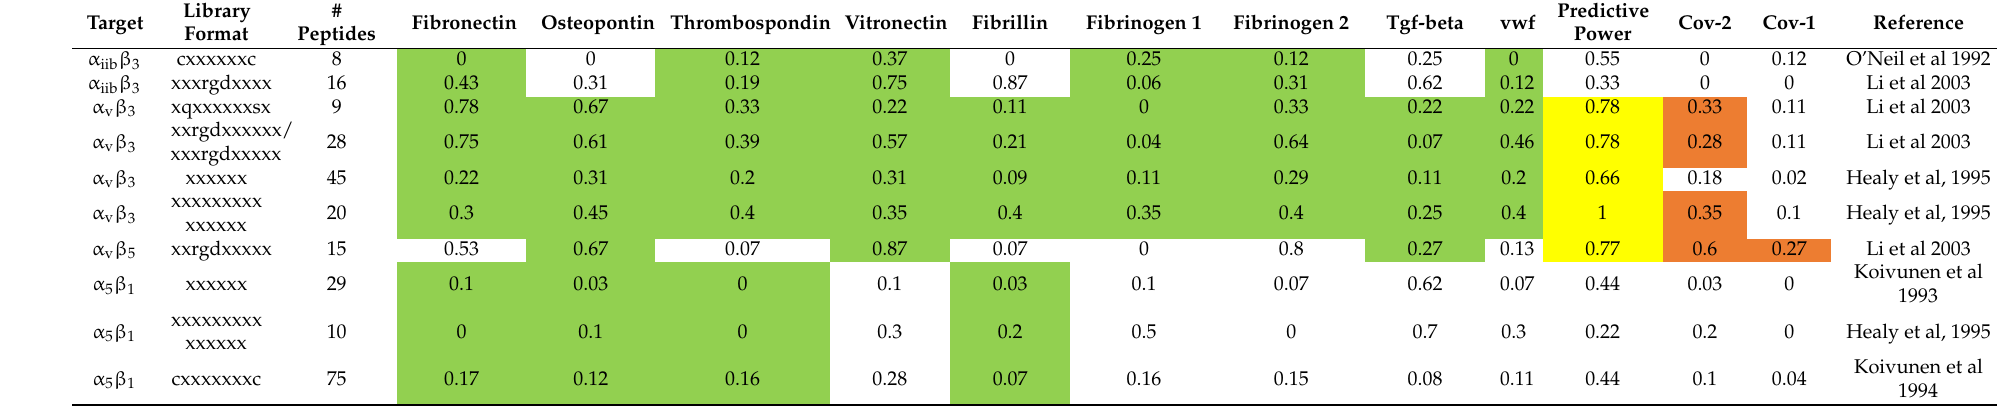
Table 2. A re-analysis of phage display data from experiments in which combinatorial phage-displayed peptide libraries were screened for affinity to four different integrins. Peptide sequences were reported by publications dating from 1992 to 2003. The first column indicates the integrin target for the affinity screen. The second column indicates the format of the peptide. Those peptides bracketed by cysteines, “c”, were assumed to be cyclic due to the predicted formation of disulfide bonds between the first and last displayed amino acid. “x” indicates a position where a random amino acid was inserted. In some cases, specific amino acids were inserted at defined positions within the peptide, and those are indicated according to the one-letter amino acid code. In column 3, the # of unique peptide sequences reported is given, a number which varied dramatically from study to study. The next 9 columns indicate the percentage of peptides that exhibited similarity to the RGD motif region of each of 9 known integrin ligands. There are two columns for fibrinogen corresponding to the two RGD motifs in the alpha-chain. “Similarity” was judged by the program MATCH using default parameters [33]. Green shading indicates those integrins that bind each ligand. For instance, osteopontin binds α v β 3 , α v β 5 and α 5 β 1 , but not α iib β 3 . Empirically, when 20% or more of the selected peptides exhibited similarity for the RGD motif of an integrin ligand, it indicated that the ligand was likely to bind that integrin. The 12th column is predictive power defined as the percentage of correct predictions of integrin specificity made by each of the 10 library screenings. Yellow shading indicates a “predictive power” of 2/3 or greater. The next two columns are the proportion of peptides exhibiting similarity to the RGD/KGD motifs in CoV-2 and CoV-1 spike proteins. Brown shading indicates those screens that resulted in greater than 20% of the peptides exhibiting similarity to the motif region. The last column is the citation for the publication that reported the peptide